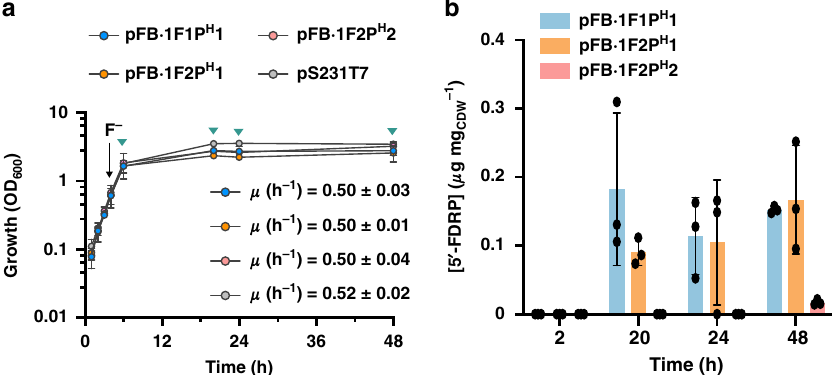
Fig. 5 In vivo biosynthesis of fl uorosugars in engineered P . putida . a Growth curves of P. putida KT2440::FRS-T7RNAP containing the plasmids modules described in Fig. 4b, compared to the growth pro fi le of P. putida KT2440::FRS-T7RNAP bearing an empty vector (pSEVA231). F − addition to the cultures is indicated with a black arrow. Green arrows indicate the points when cultures were harvested to test 5 ′ -FDRP biosynthesis. Average and standard deviations of the speci fi c growth rates ( μ ) after the addition of F − are shown in the plot for each engineered strain. Error bars correspond to standard deviations of three different biological replicates. b Extracellular concentration of 5 ′ -FDRP after 2, 20, 24, and 48 h of induction of the synthetic circuit with NaF. Error bars correspond to standard deviations of three different biological replicates. CDW cell dry weight. Data are presented as mean values and error bars correspond to standard deviations from three biological replicates. Source data are provided as a Source Data fi